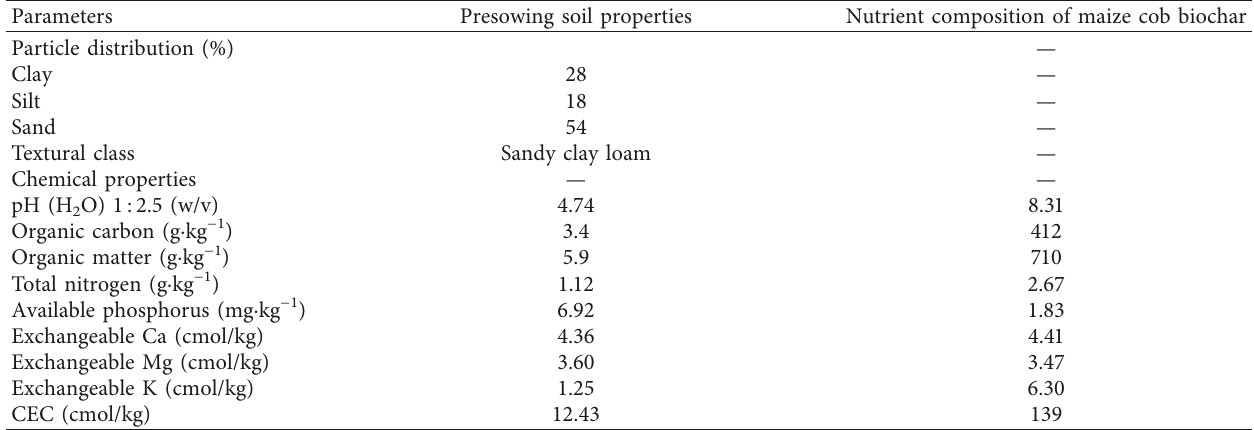
Table 1: Physico-chemical characteristics of study site soil before planting and corn cob biochar nutrient composition at Guto Gida, Western Ethiopia.